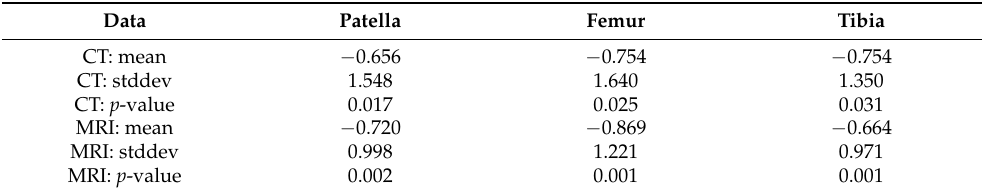
Table 8. Mean, standard deviation (stddev), and p -values calculated for the one-sided t -test for the following bones: patella, femur, and tibia.